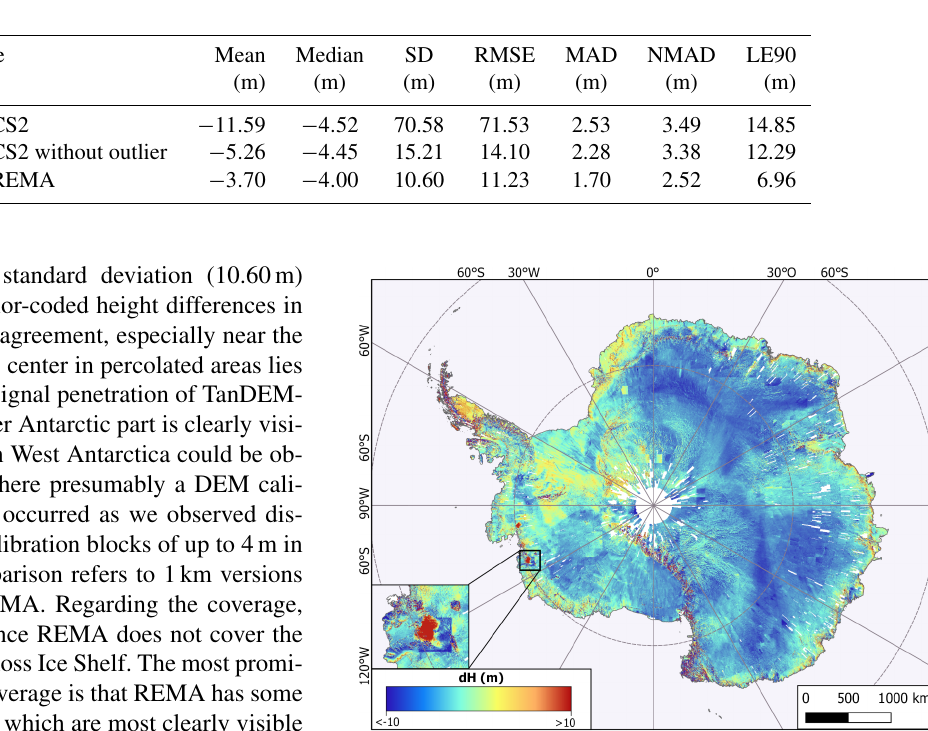
Table 4. Accuracy numbers for height differences of TanDEM-X minus CryoSat-2 (CS2) DEM (Slater et al., 2018) and REMA (Howat et al., 2019).